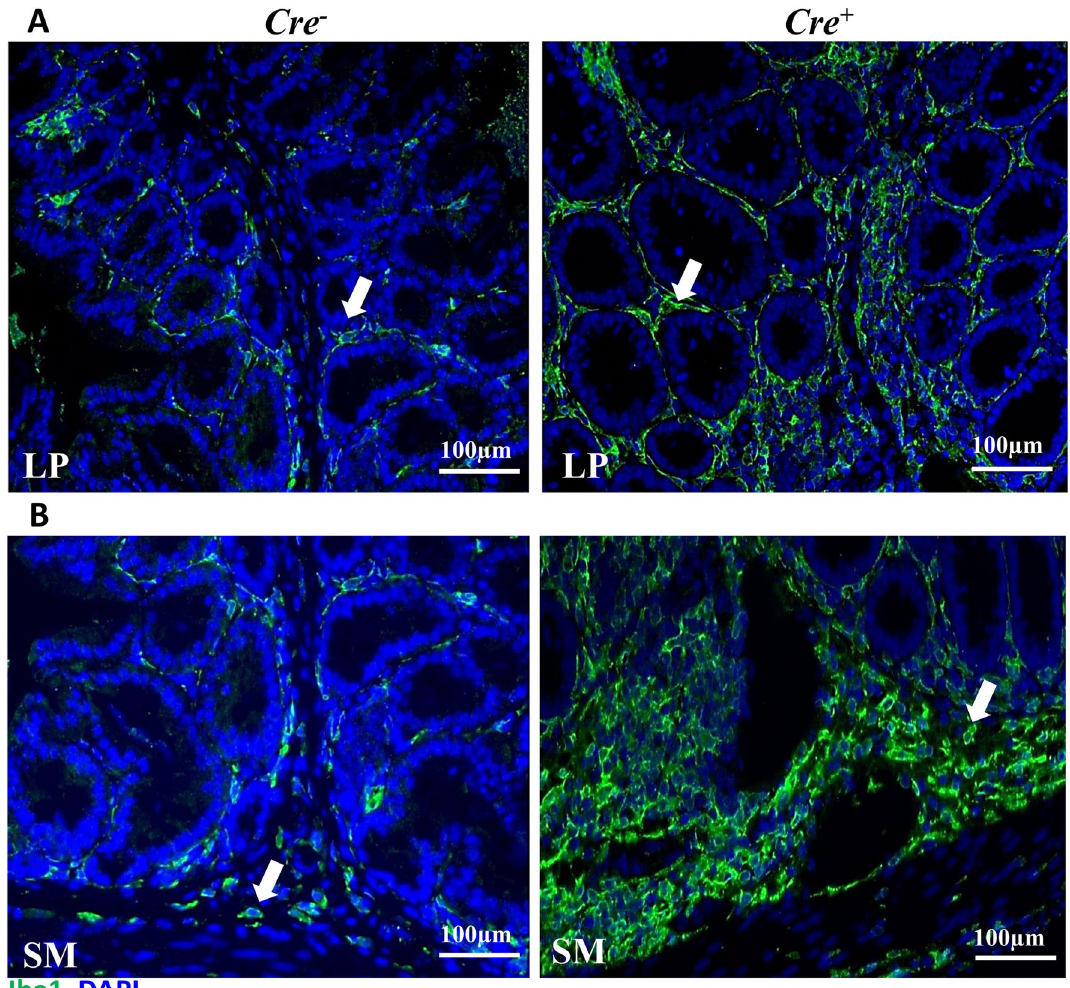
Figure 5. Intrinsic IL10R signaling prevents the accumulation of round macrophages within the colonic submucosa. ( A ) Immunofluorescent images from the colon of representative Cdcs1 + / + Il10ra fl/fl LysMCre − (Cre − ) and Cdcs1 + / + Il10ra fl/fl LysMCre + (Cre + ) mice showing the ramified shaped Iba1 + cells within the colonic lamina propria (LP) indicated by the arrows. ( B ) Increased density of Iba1 + round shaped cells (arrows) within the submucosa (SM) of Cre + mice compared to Cre - mice. 20 × magnification, Scale bar indicates 100